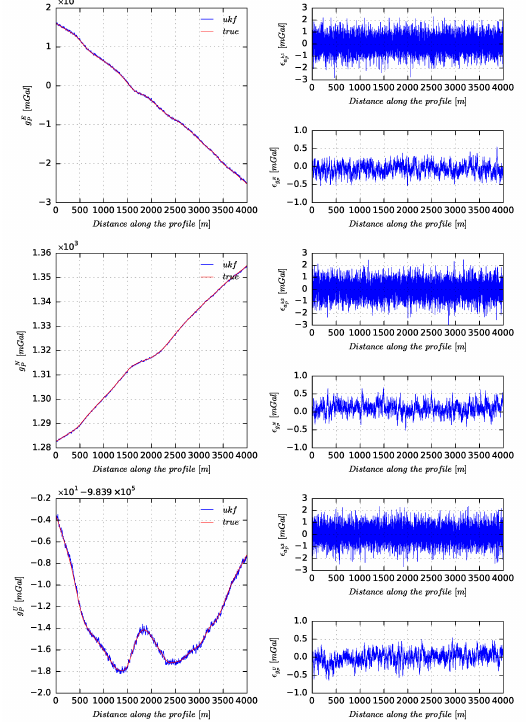
Figure 12: On a simple example, the Unscented Kalman Filter induces a sensible noise level reduction of about 4 . 5 on the three components of the gravity